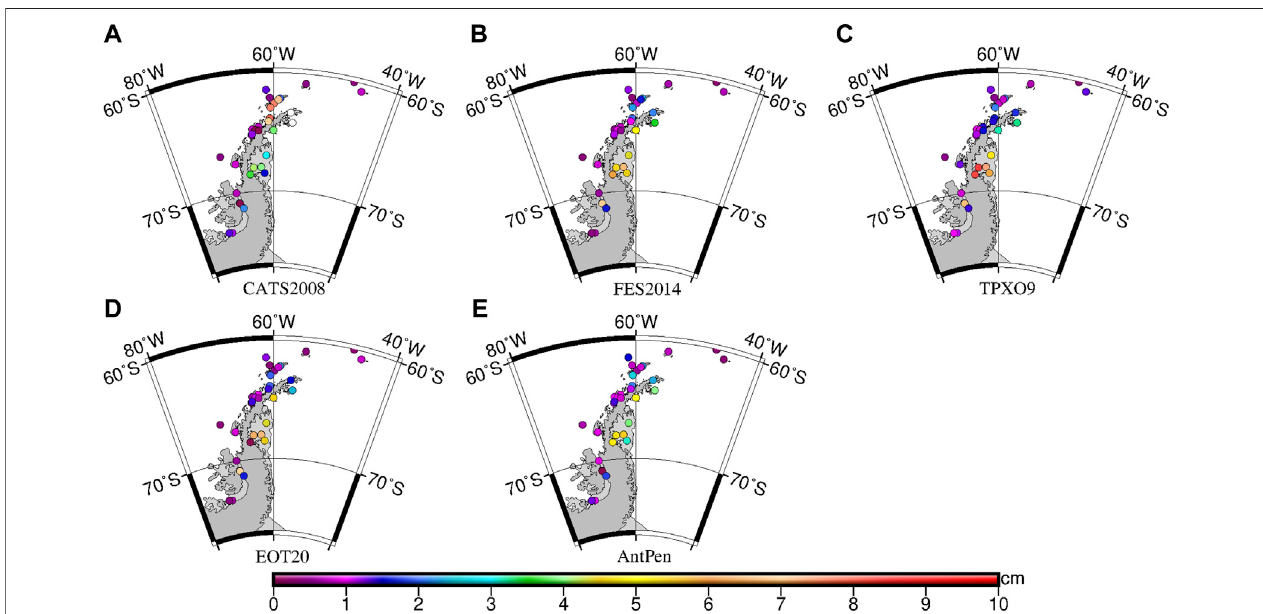
FIGURE 6 | RSS of each station in the Antarctic Peninsula of (A) CATS2008, (B) FES2014, (C) TPXO9, (D) EOT20, and (E) AntPen.